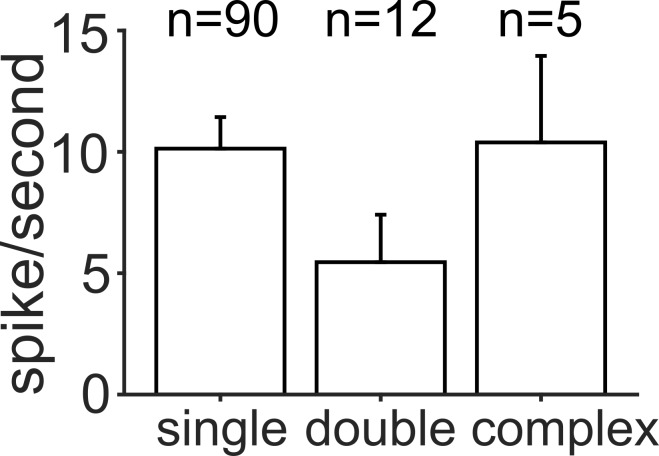
Magnitude of the trial-averaged response at the best frequency and level combination, calculated from spike rates measured with microelectrodes.Responses were averaged across all neurons in each FRA class, pooled across penetrations and ferrets (mean ± SEM). The number of neurons per group is given above each bar.